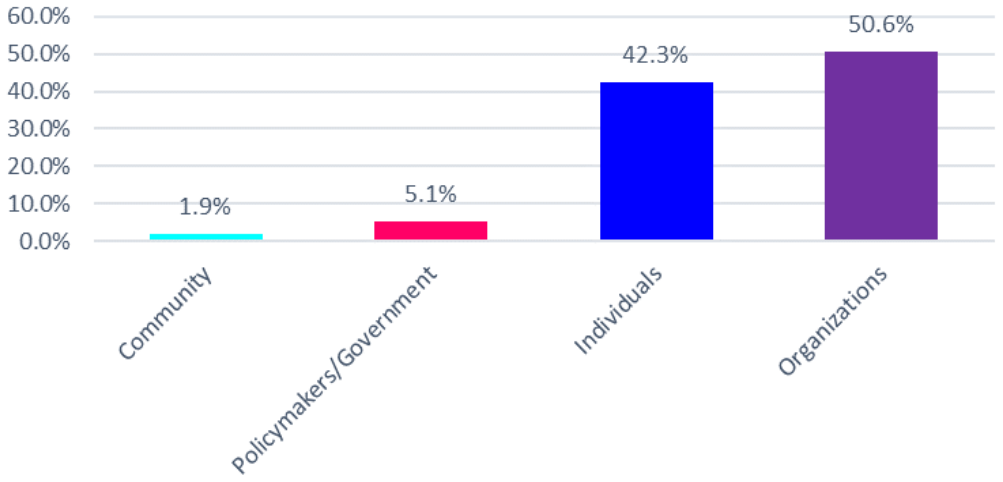
Figure Figure 1. Stakeholder representation: concerns about discrimination in employer-sponsored wellness programs